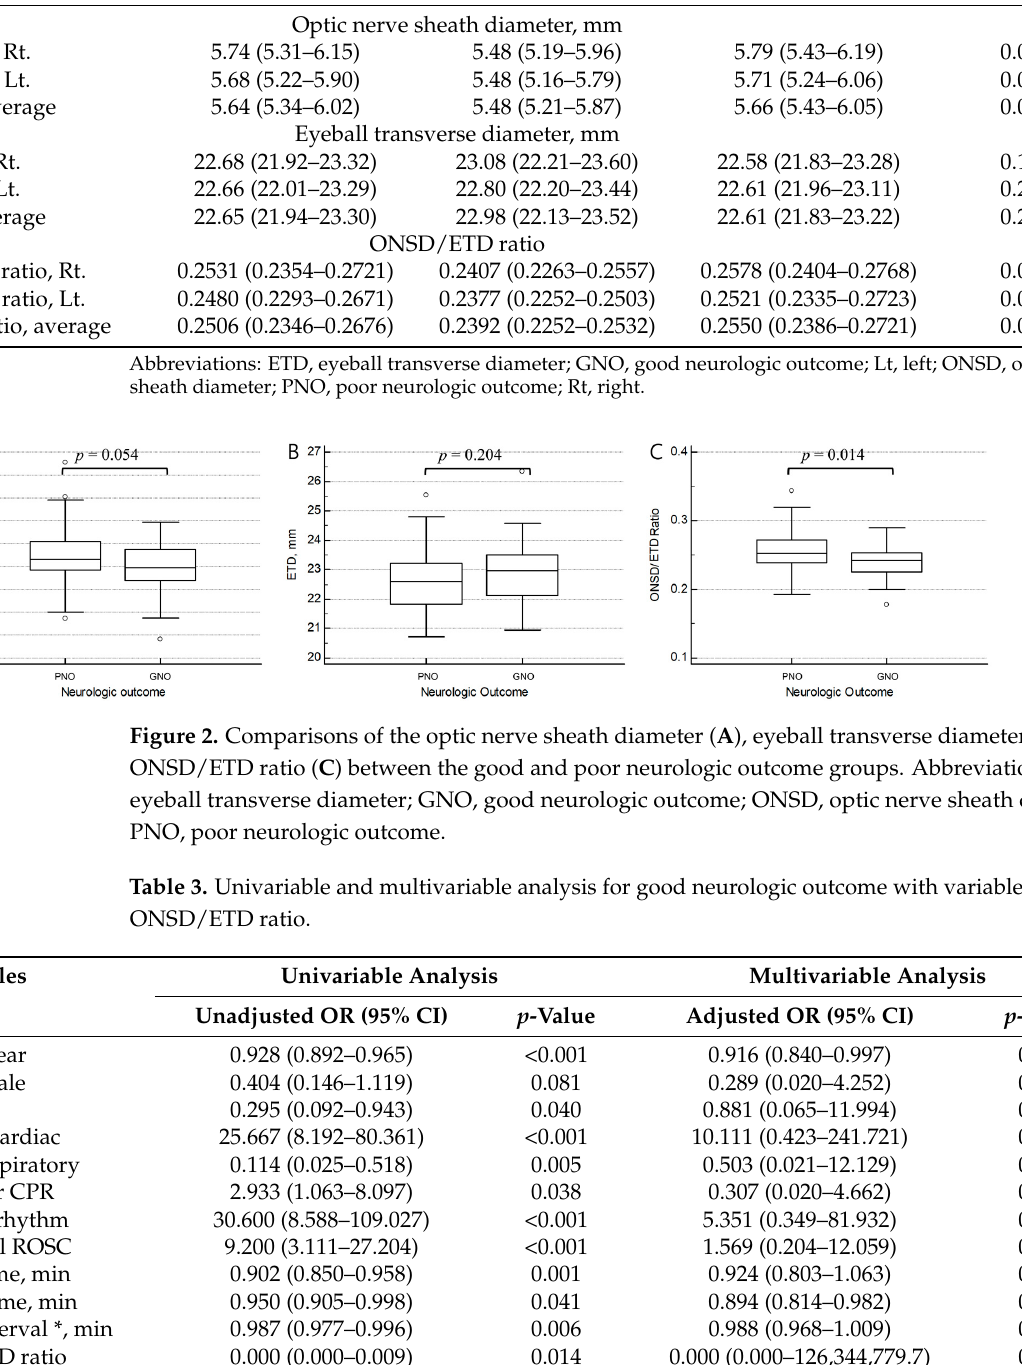
Abbreviations: ETD, eyeball transverse diameter; GNO, good neurologic outcome; Lt, left; ONSD, optic nerve sheath diameter; PNO, poor neurologic outcome; Rt, right.